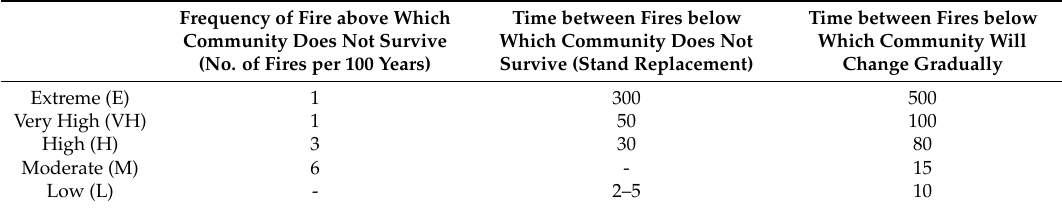
Table 2. Fire sensitivity categories used in the vegetation model